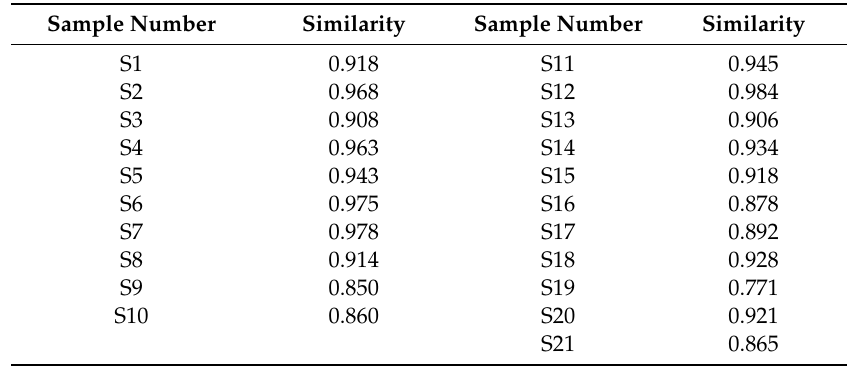
Table 2. Similarity of fingerprints’ chromatogram of toad venom extracts from 21